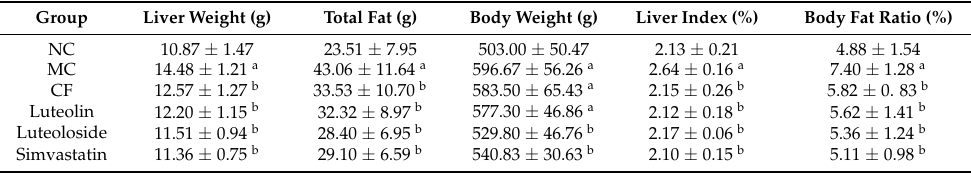
Table 4. Body weight, liver weight, liver index, total fat, and body fat ratio in each group.